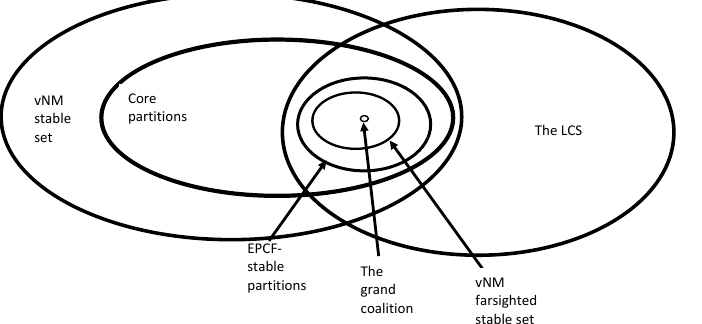
Figure 1. Relationship between stable coalition structures for PMAS profit games under different stability